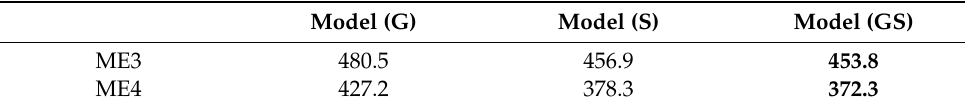
Figure 3. GAMMs plot of DMS concentrations (in nmol L − 1 ) during ( a ) ME3, and ( b ) ME4 against time. The bold line represents the average of the treatment’s duplicates, the points are the actual measurements and the clearer area around the average represents the deviation. Note the differences in vertical scales. Table 5. DMS concentration AICs from models (G), (S) and (GS) for ME3 & ME4. The model providing the best fit is the one with the lowest AIC (in bold). The (G) model fits a common trajectory regardless of treatment, while the (S) and (GS) models incorporate treatment effects.